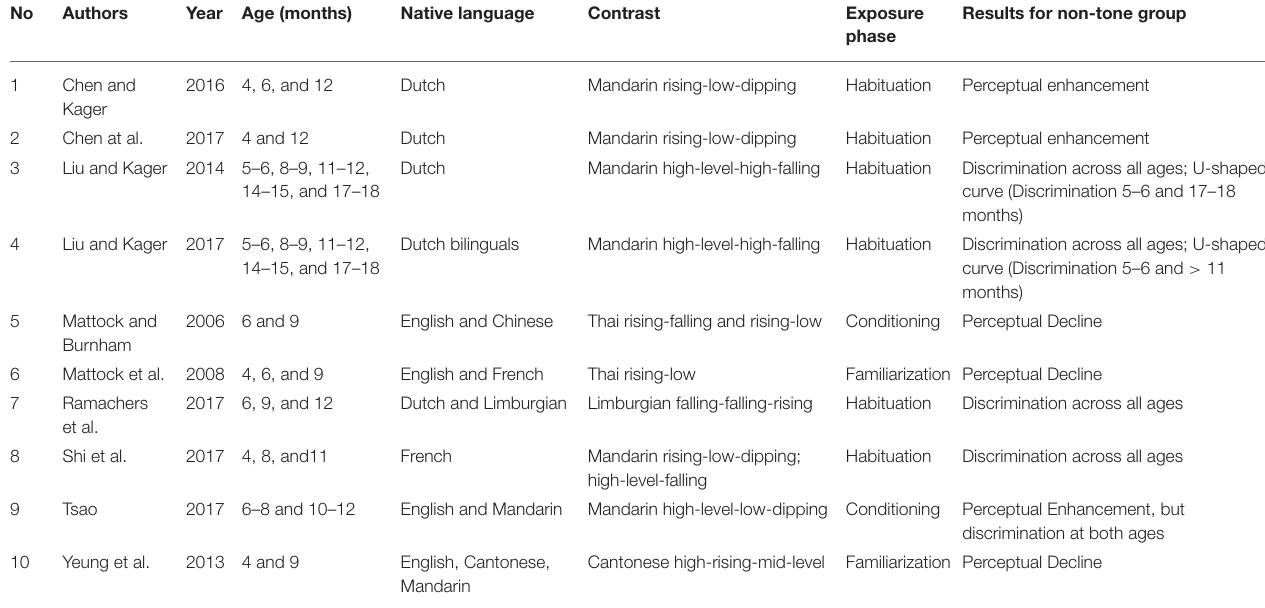
TABLE 1 | Summary of the previous results on infant lexical tone